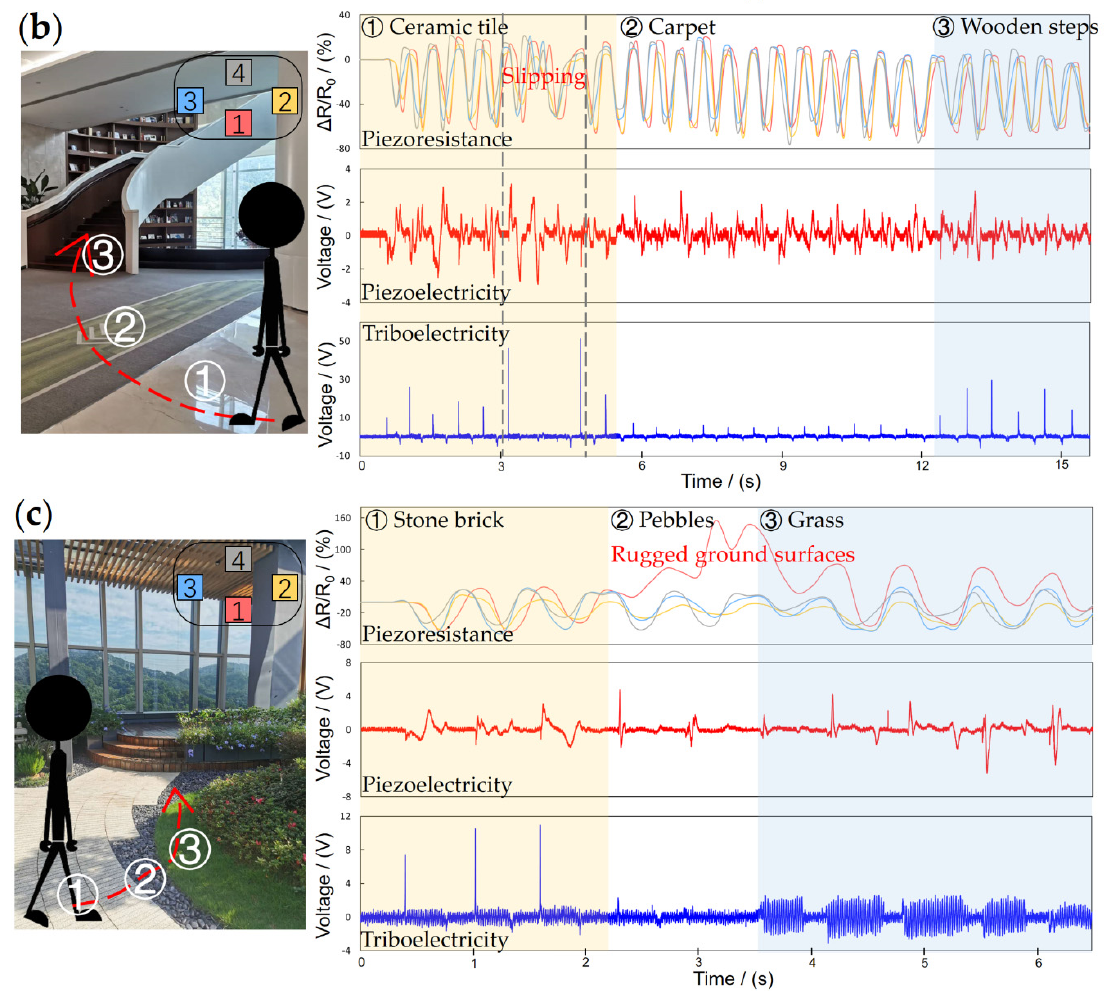
Figure 11. The experiment of FMSS mounted on the bottom of the tester’s foot. The traverse paths and signal result in a typical ( a ) hall, ( b ) office, and ( c ) garden scenario.